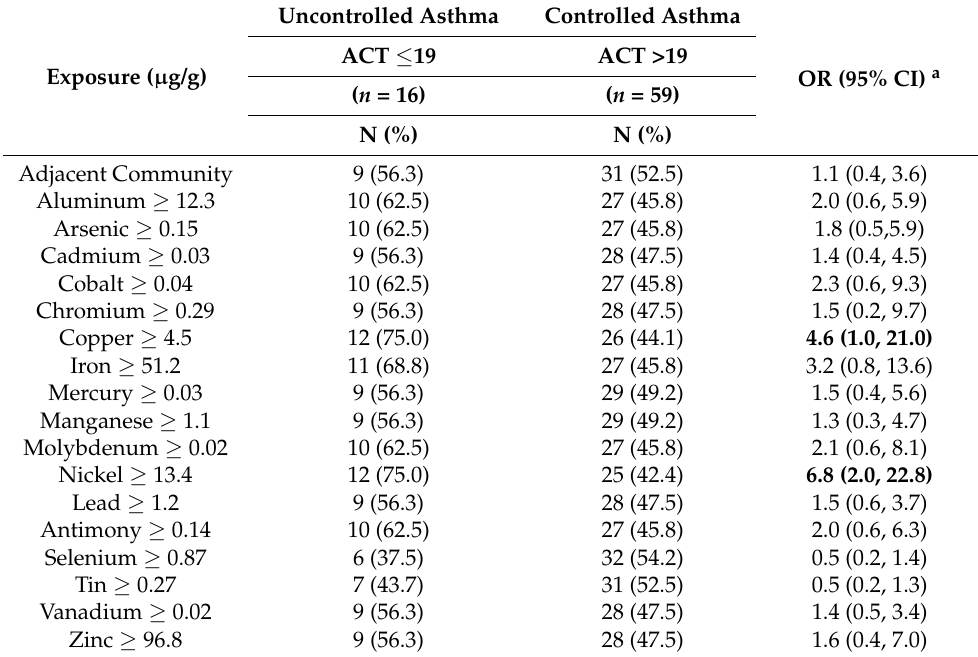
Table 4. Associations between toenail metal concentrations and asthma control among children with asthma ( n =